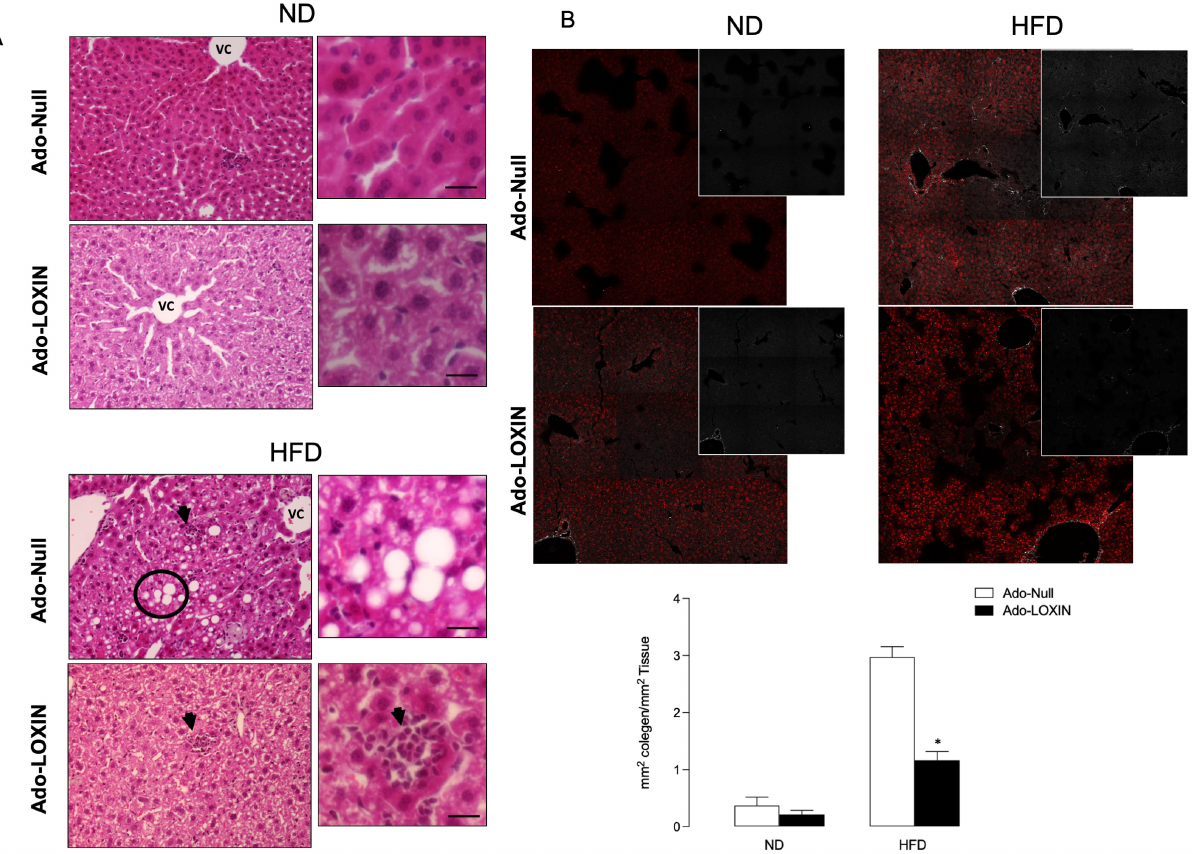
Figure 5. Histopathological analysis of liver sections. ( A ) Representative pictures of mice divided into two groups, normal diet (ND) and high-fat diet (HFD) mice and infected with an adenovirus vector expressing LOXIN (Ado-LOXIN) or empty vector (Ado-Null) via the tail vein. Arrows repre- sent inflammatory cell infiltration, and the circles indicate hepatocellular hypertrophy or damaged hepatocytes. Vc, central vein. ( B ) Images of collagen fibers in liver tissue were recorded with second-harmonic generation (SHG) microscopy. Collagen deposits are shown in Sirius Red staining or grey (insert). Values are expressed as mean, and SEM n = 5. Scale bars indicate 10 μ m. The figure shows the quantification of collagen fibers ( n = 5). Statistical significance is represented as * p < 0.05. Second-harmonic generation (SHG) was used to determine fibrillar collagen and hepa- tocyte morphology changes during liver fibrosis progression. Figure 5B shows changes in collagen deposit by Sirius Red staining (insert shows collagen deposit in grey color). In ND livers, hepatocytes are healthy and low collagen is distributed. HFD results in high colla- gen distribution that Ado-LOXIN blocks. Thus, quantification of SHG images shows that HFD induces a 15-fold increase in fluorescence (0.2 v/s 3.16 mm 2 collagen area/total area), which is significantly inhibited by Ado-LOXIN (1.3 mm 2 collagen area/total area). No differences were observed in the fluorescence intensity under ND and treatment with